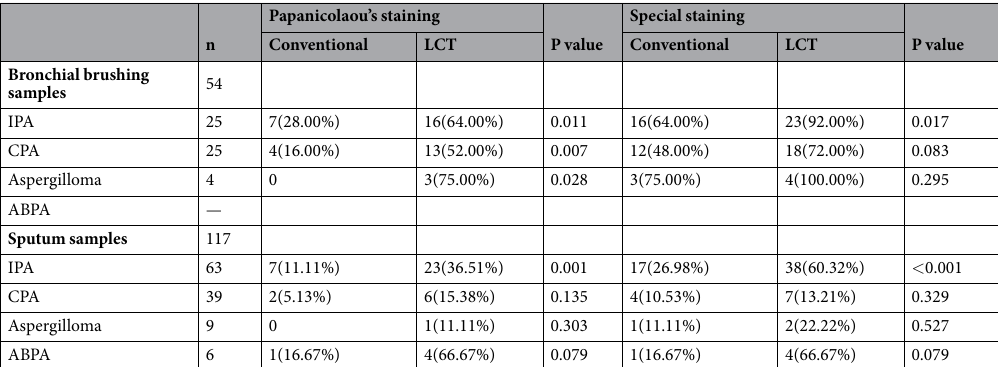
Table 3. Results of conventional and liquid-based cytopathology for diagnosing different types of pulmonary aspergillosis IPA: invasive pulmonary aspergillosis; CPA: chronic pulmonary aspergillosis; ABPA: allergic bronchopulmonary